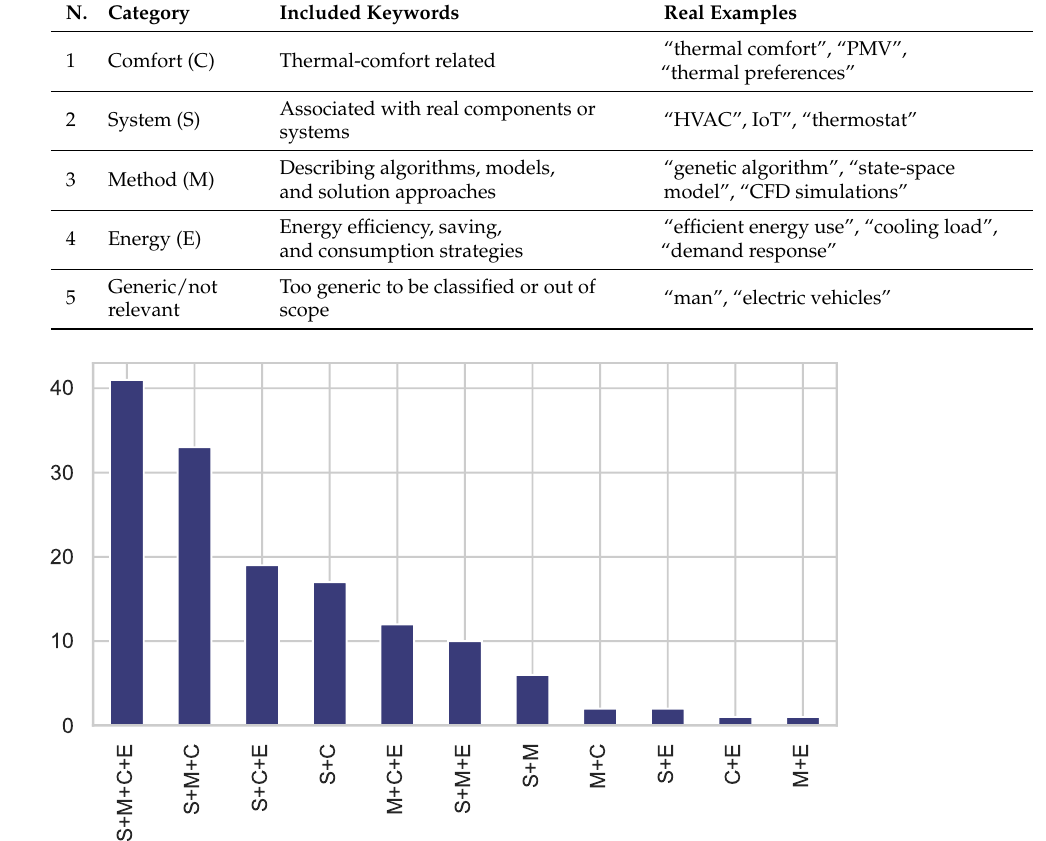
Table 2. Keyword categories for manual classification.